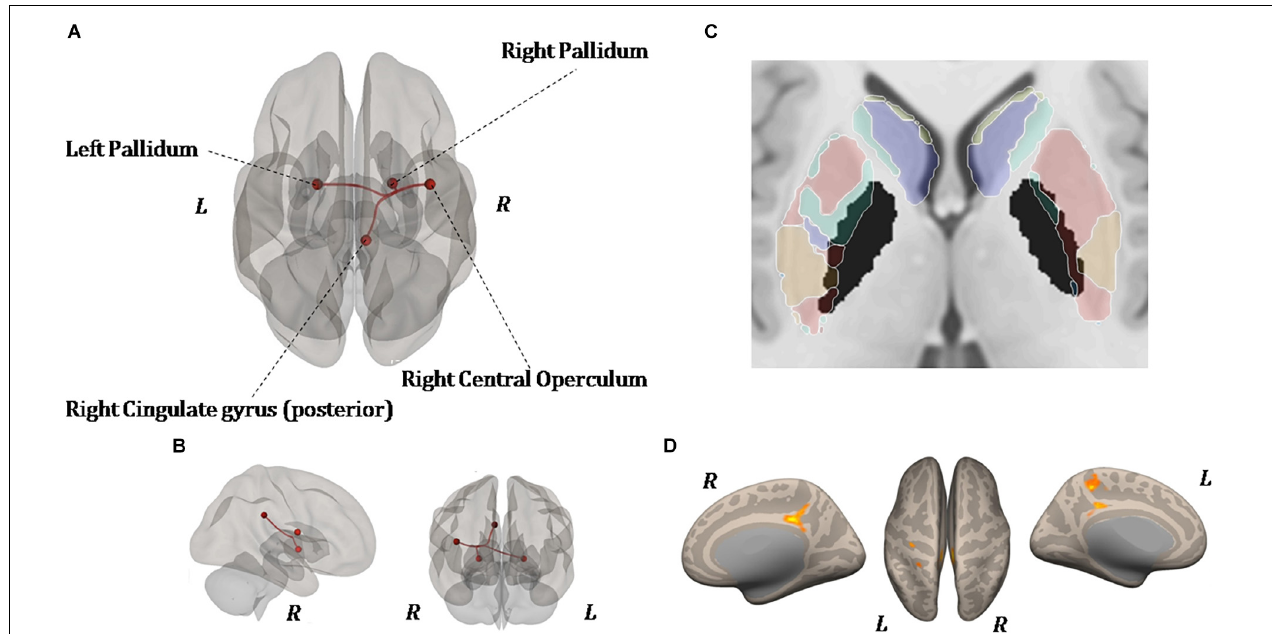
FIGURE 6 | Resting-state functional connectivity differences. Functional image processing and statistical analyses demonstrated increased cortico-subcortical connectivity with respect to pretraining stage. In (A,B) the region of interest (ROI)-to-ROI analysis shows significant functional connectivity changes: both globus pallidi show increased connection to the right central operculum, right cingulate gyrus posterior, and left sensorimotor cortex. In (C,D) , seed-to-voxel analysis (left and right globus pallidi as seed) demonstrates a functional connectivity between the left primary motor cortex and left superior frontal gyrus. In (D) , the colored areas overlaid on flattering images of the brain represent the areas of cortical